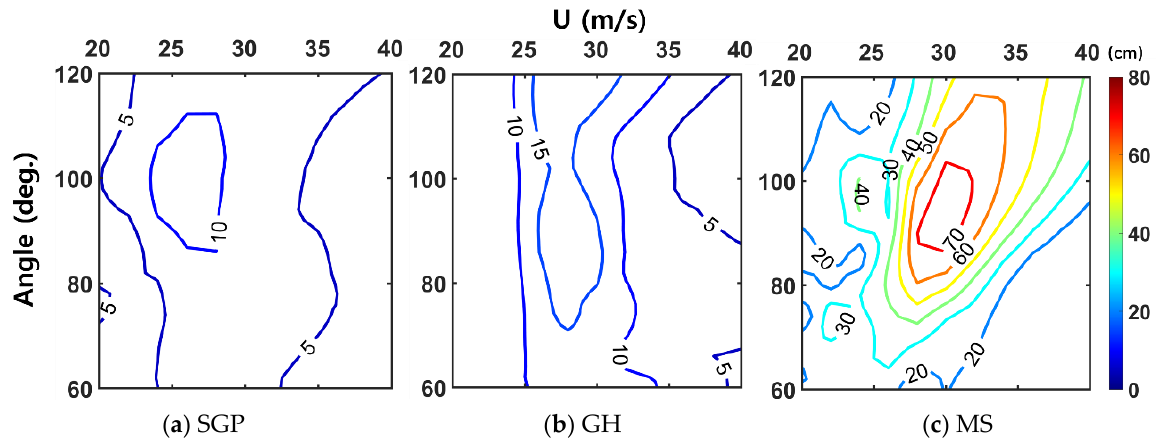
Figure 12. Expected amplitudes (cm) of the long ocean waves at ( a ) SGP, ( b ) GH, and ( c ) MS in the Korea Strait if an atmospheric pressure disturbance propagated eastward with various isobar angles ( θ in Figure 5) and traveling speeds ( U ) from 20 to 40 m/s.